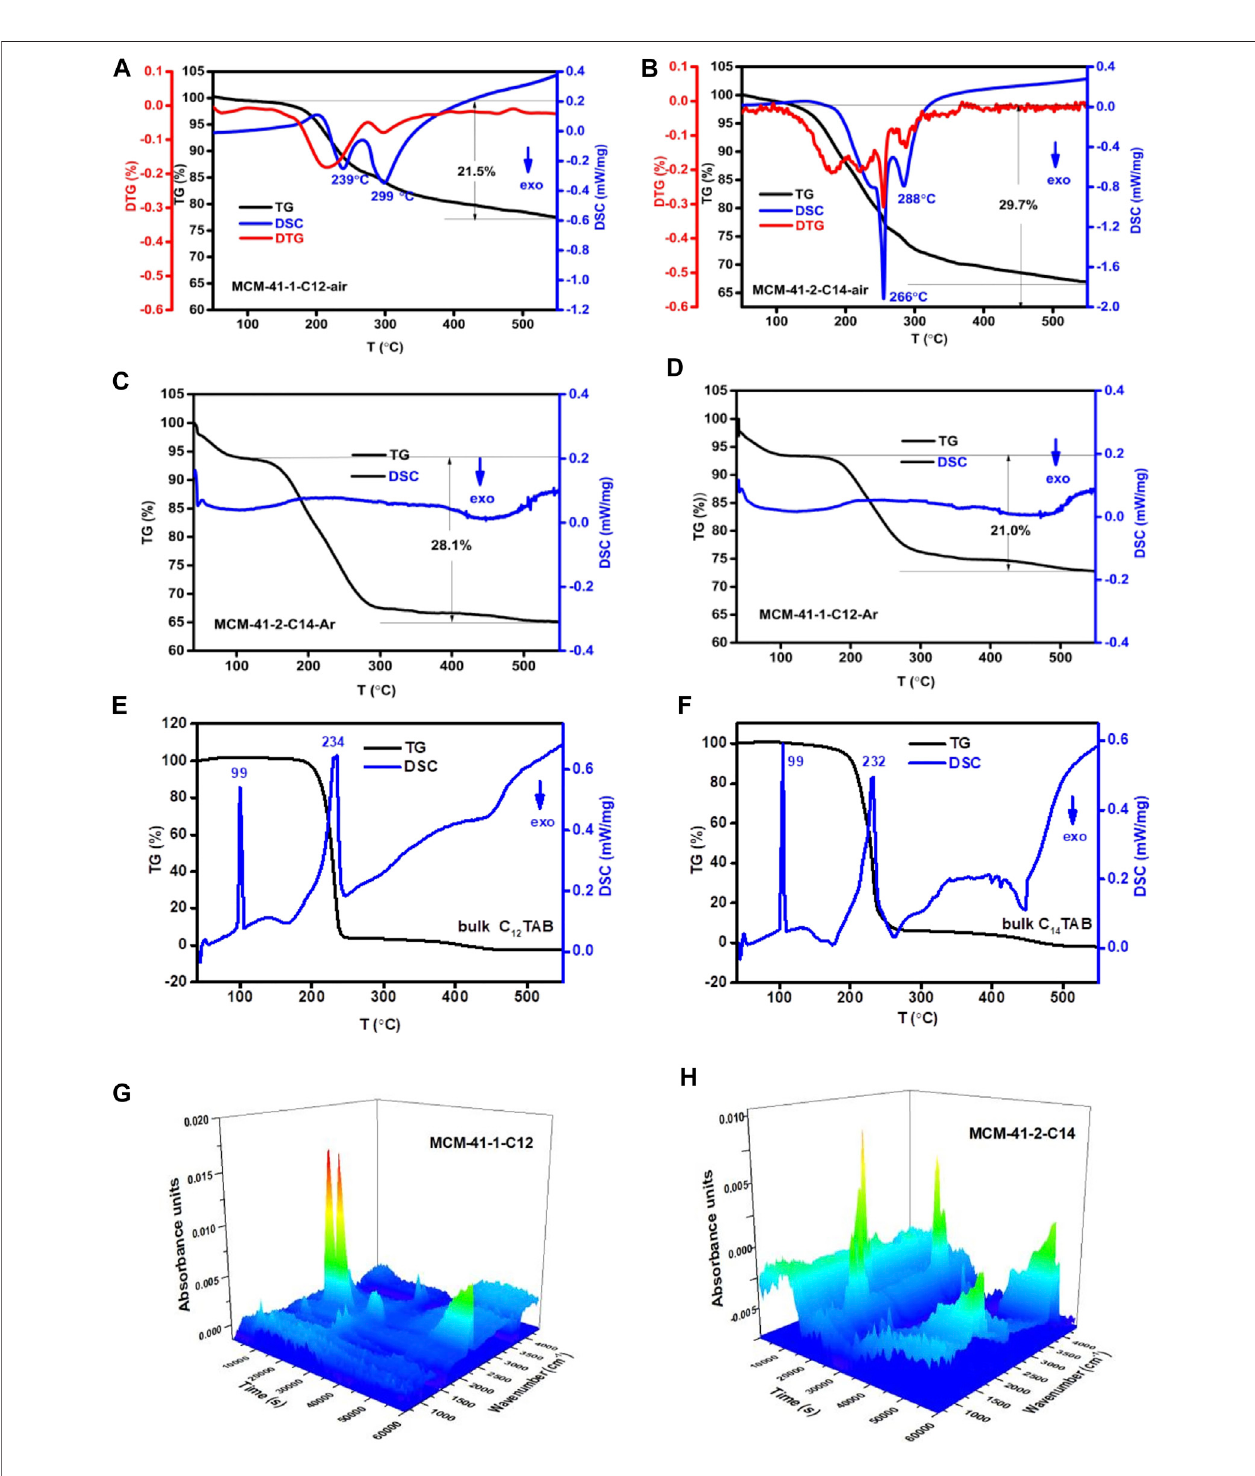
FIGURE 2 | Thermal analysis curve (TG and DSC) of (A) uncalcined MCM-41-1-C12 (air atmosphere), (B) uncalcined MCM-41-2-C14 (air atmosphere), (C) uncalcinedMCM-41-1-C12(argonatmosphere),( D) C 14 TABinsideuncalcinedMCM-41-2-C14(argonatmosphere), (E) bulkC 12 TAB(airatmosphere), (F) bulkC 14 TAB (air atmosphere). (G) Infrared 3D spectrum of uncalcined MCM-41-1-C12 escaping gas. (H) Infrared 3D spectrum of uncalcined MCM-41-1-C14 escaping gas.